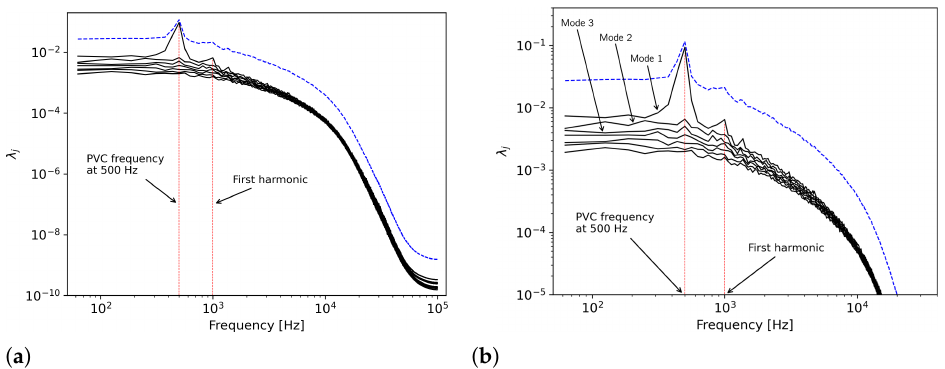
Figure 5. SPOD eigenvalues as a function of the frequency and normalized by the total energy over all frequencies. ( a ) Complete spectrum. ( b ) Zoom on the region of interest.